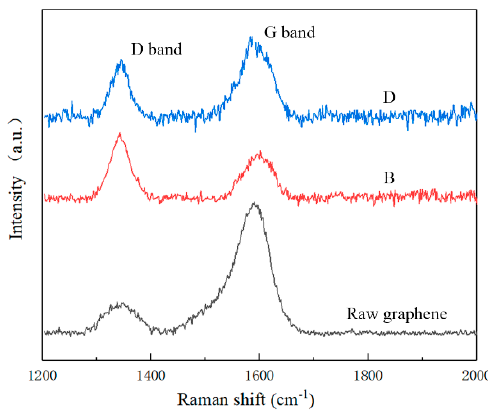
Figure 5. Raman spectra for raw graphene, composite B, and composite D.